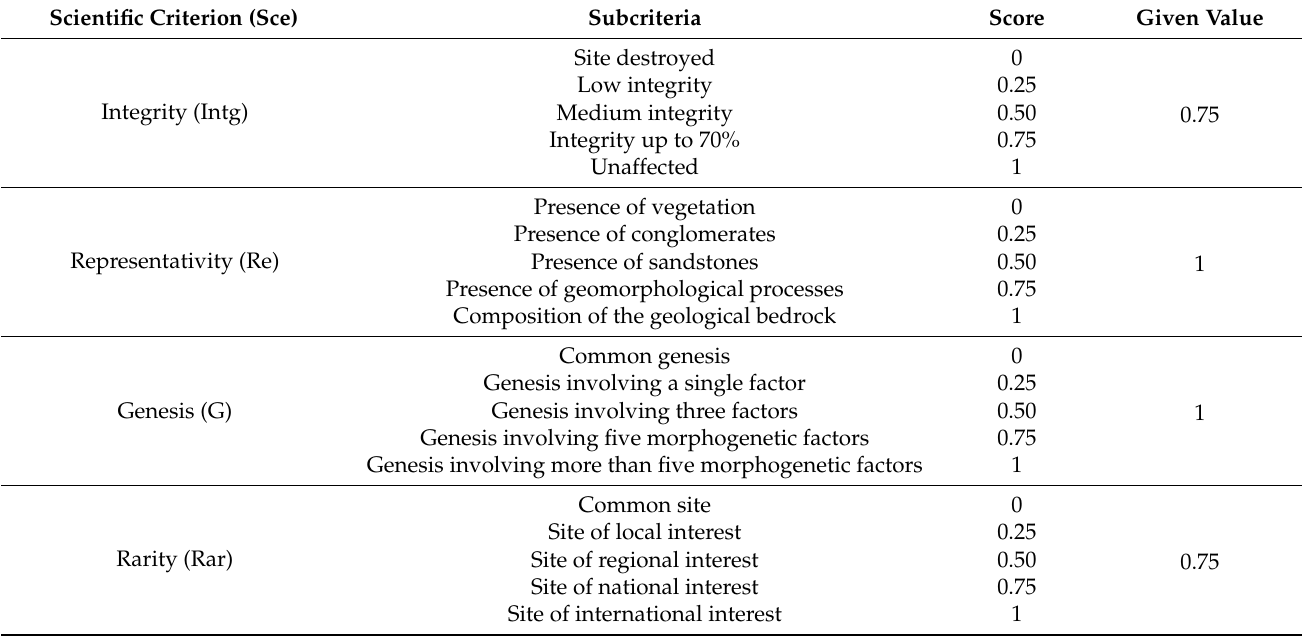
Table 1. Geomorphological value—the scientific criterion